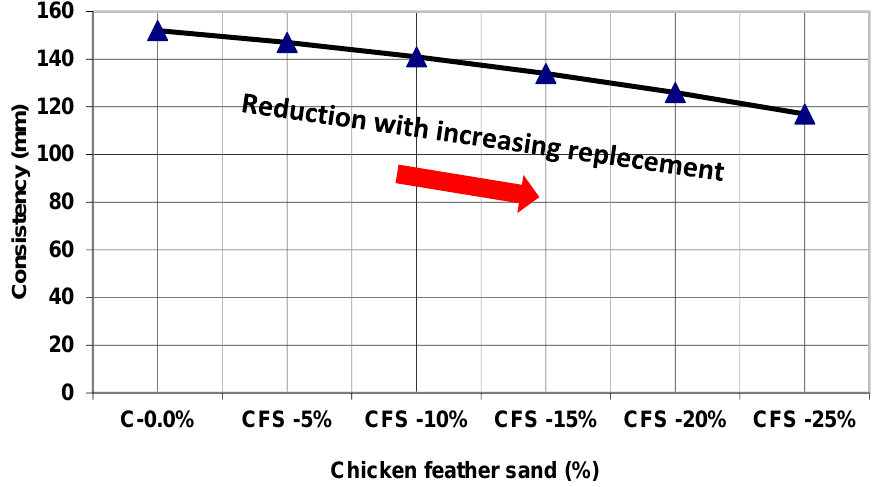
Figure 6. Consistency values for all mixtures.